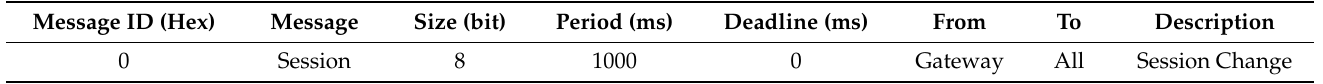
Table 3. Definition of a gateway’s message in the message set